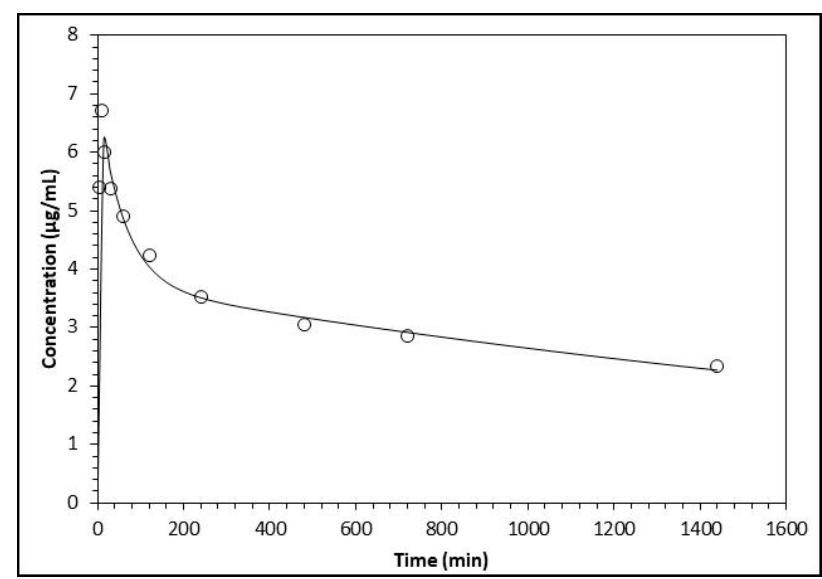
Figure 4. Analysis of the variation of plasma concentration of p -HPAA (open circles) with respect to the time in minutes. The line represents the prediction of the behavior of the concentration following a two-compartment model.